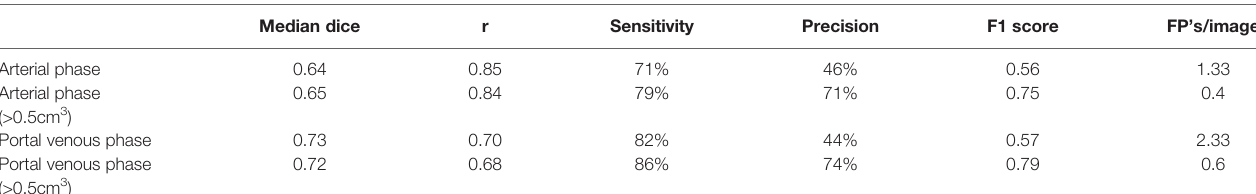
TABLE 4 | Results of tumor segmentation